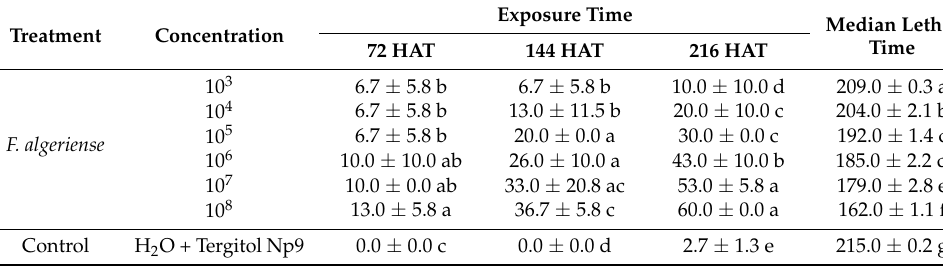
Table 9. Mean mortality ( ± sd) and Median Lethal Time of H. armigera adults exposed to Fusarium algeriense for 216 h of two season experiments. Means of the same column followed by the same letter are not significantly different (Tukey test, a = 0.05), Median Lethal Time (hours ± sd) was estimated by the Kaplan–Meier method (F = 5.232, df = 6, p < 0.001), HAT: Hours After Treatment.